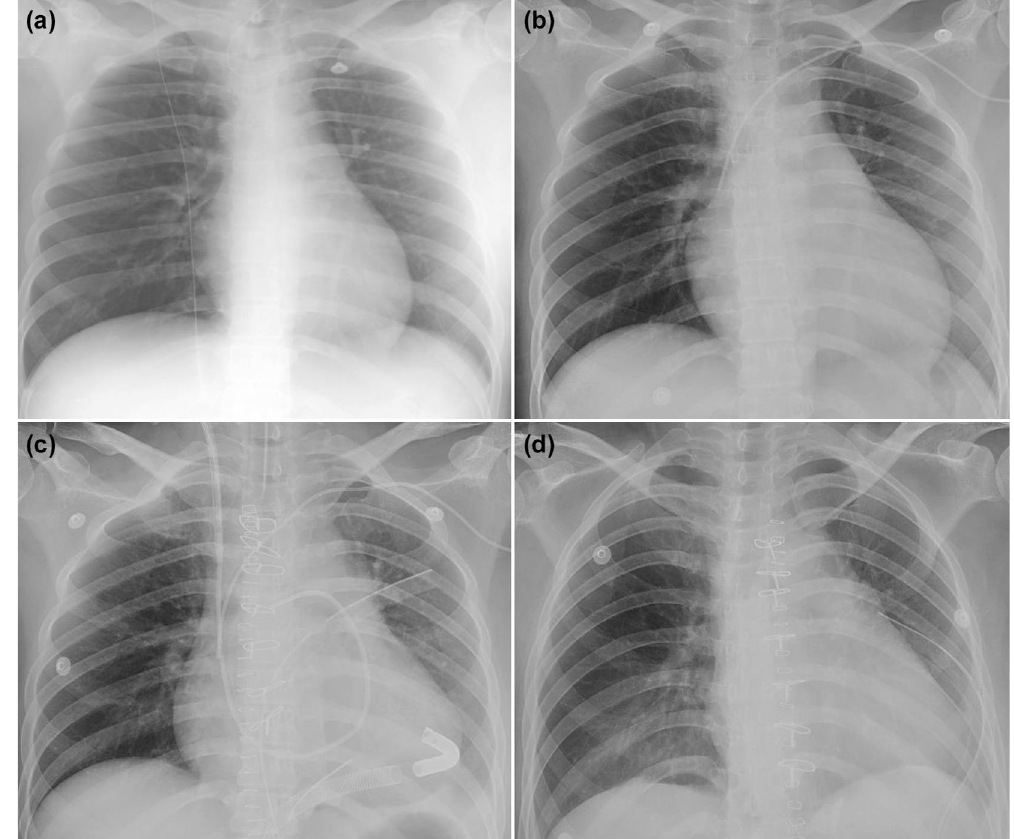
Figure 2. Representative postpartum patient who received ECMO. A 34-year-old pregnant woman with a fetus with a gestational age of 16 weeks was diagnosed with breast cancer stage IA, underwent right total mastectomy, and received adjuvant doxorubicin and cyclophosphamide chemotherapy. She delivered at a gestational age of 36 weeks and was discharged without significant symptoms ( a ). After 3 weeks, she presented to the emergency room with dyspnea and palpitations ( b ). An echocardiogram revealed decreased biventricular systolic function with an LVEF of approximately 25%. After 2 weeks of intensive care unit management with dobutamine and volume control, her symptoms did not improve. Emergency extracorporeal LVAD insertion was performed, and 8 days after extracorporeal LVAD insertion ( c ), she underwent heart transplantation ( d ). ECMO extracorporeal membrane oxygenation, LVEF left ventricle ejection fraction, LVAD left ventricular assist